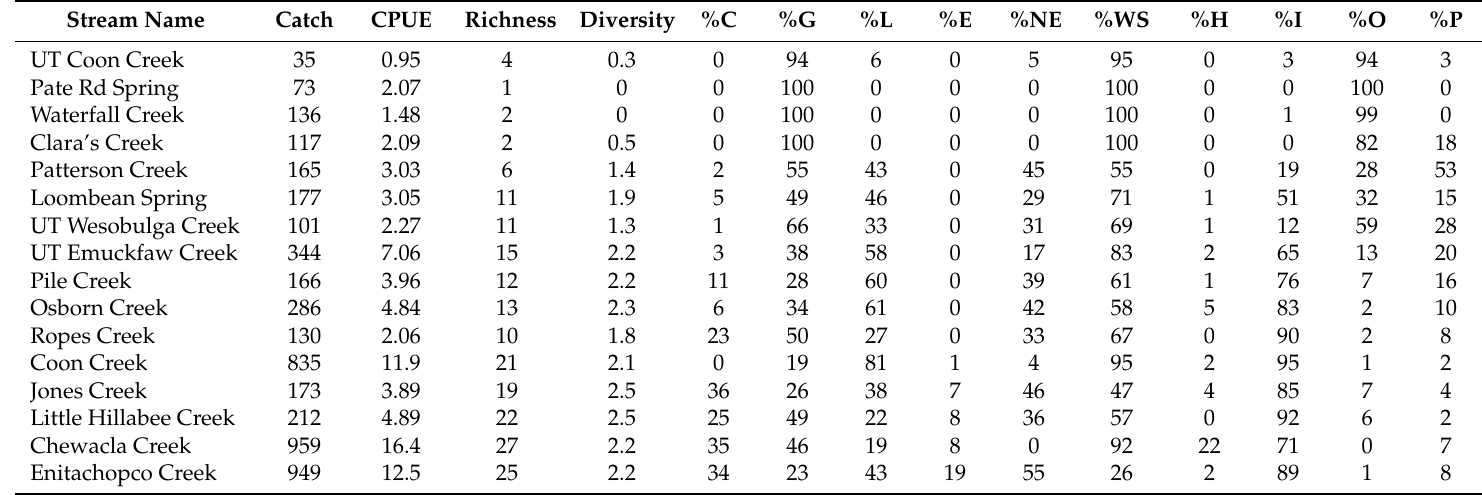
Table 5. Total catch, catch-per-unit-effort (CPUE) (fish/m 2 ), species richness (Richness), diversity (Shannon’s H’ ), and percent of fish assemblage as different breeding guilds (%C, %G, and %L), range distribution categories (%E, %NE, and %WS), and feeding guilds (%H, %I, %O, and %P). See text for explanations of